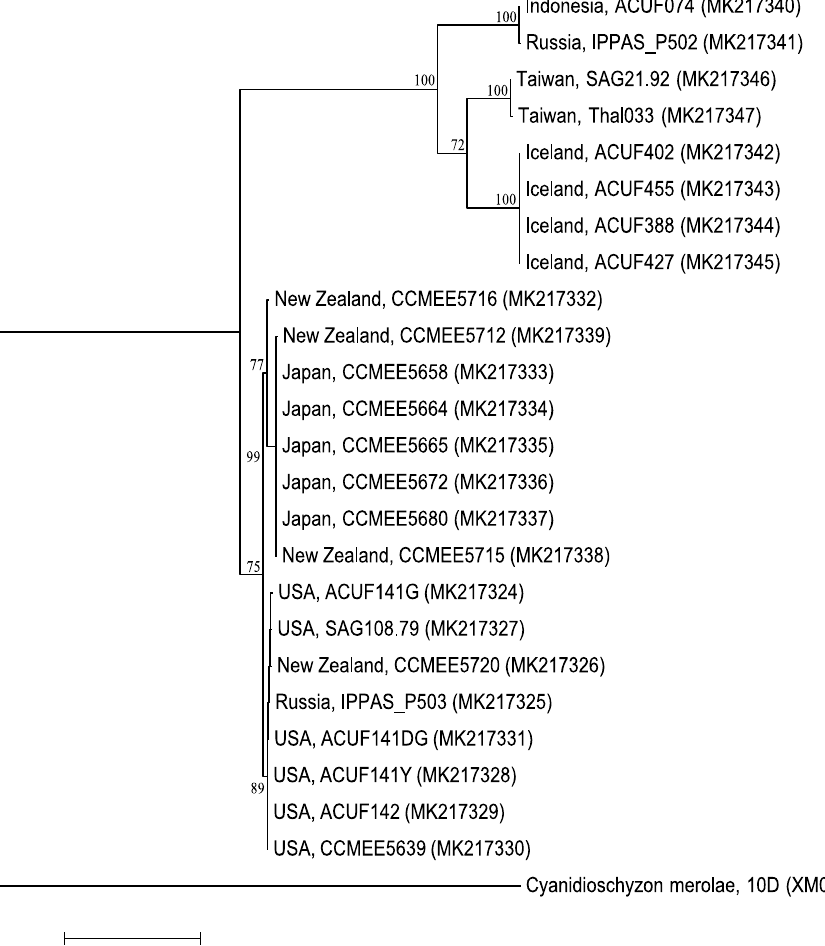
Figure 2. Maximum likelihood tree for 24 newly sequenced Galdieria Rad52 genes. Only bootstrap values > 60% were reported.